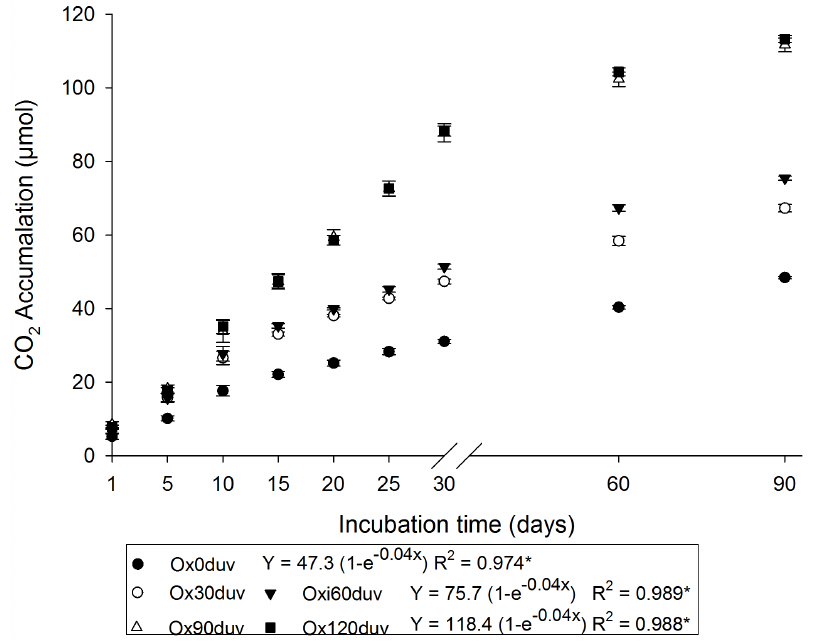
Figure 5. Respiratory activity of Pleurotus ostreatus , following 90 days of growth, before (Ox0duv) and after 30 (Ox30duv), 60 (Ox60duv), 90 (Ox90duv) and 120 days (Ox120duv) of sunlight. *Exponential equation significance (p , 0.05). There were no differences between Ox30duv and Ox60duv or Ox90duv and Ox120duv.